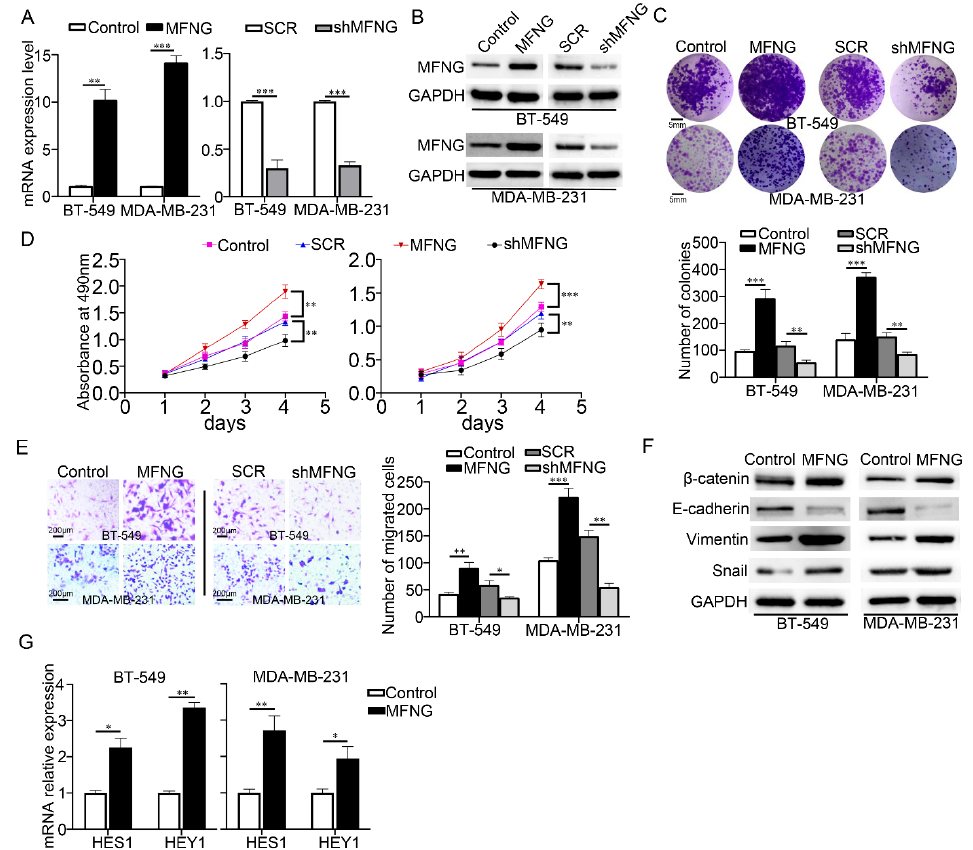
Figure 2. MFNG expression enhanced the cell growth and migration of TNBC cells. MFNG overex- pression and knockdown were detected by RT ‐ qPCR ( A ) and Western blot ( B ) in TNBC cells, SCR was short for Scramble and GAPDH served as an internal control. ( C , D ) The effect of MFNG on cell growth was examined in TNBC cells by colony formation and CCK8 assays. ( E ) The cell migration was assessed by transwell in MFNG ‐ overexpressing or knockdown TNBC cells. ( F ) Western blot analysis of epithelial–mesenchymal transition (EMT) and growth ‐ related genes in TNBC cells over ‐ expressing MFNG, GAPDH was loaded as an internal control. ( G ) RT ‐ qPCR analyzed the expres ‐ sion of Notch target genes HES1 and HEY1 in TNBC cells overexpressing MFNG, GAPDH served as an internal control. Data were analyzed using a Student’s t ‐ test. All * p < 0.05, ** p < 0.01, *** p < 0.001 .